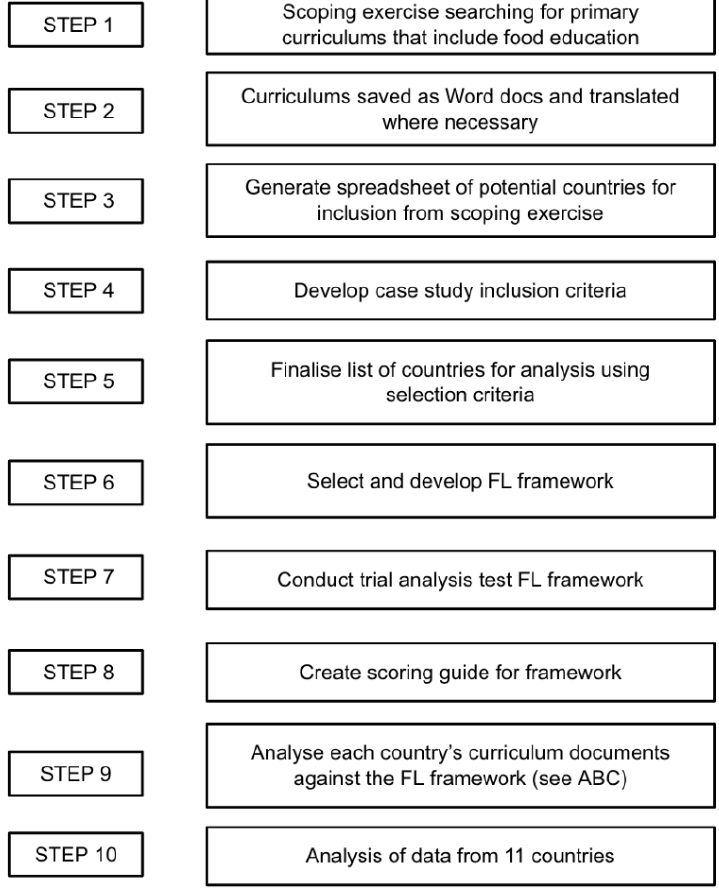
Figure 1. Research steps overview. Source: authors.